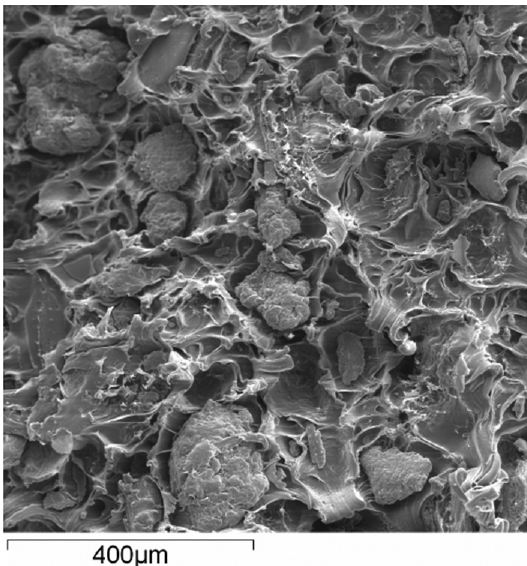
Figure 6. SEM micrograph of fractured surfaces of 90/10 LDPE/ CC mixture.